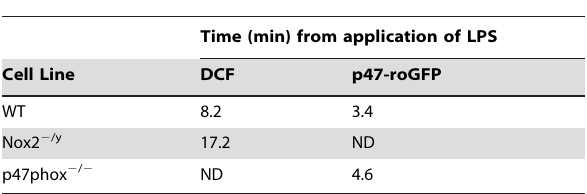
Table 1. Temporal response of DCF and p47-roGFP to